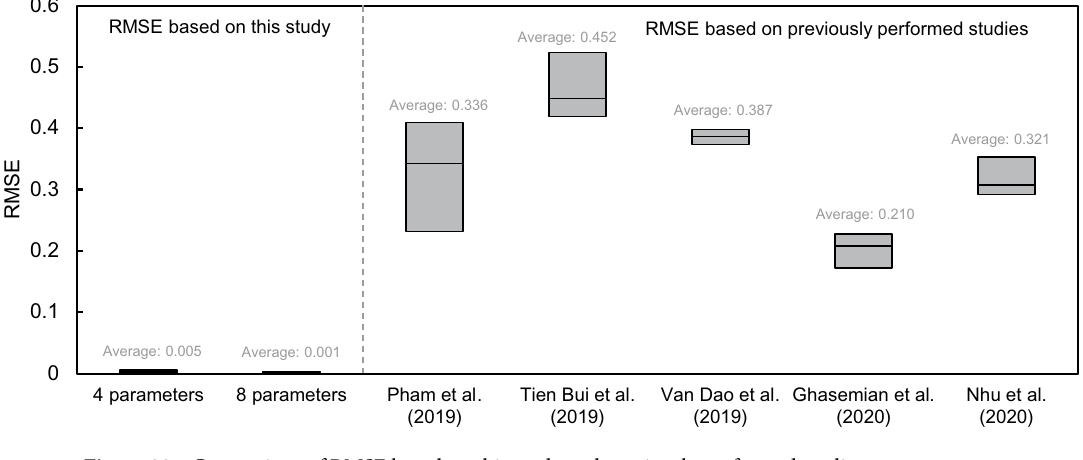
Figure 23. Comparison of RMSE based on this study and previously performed